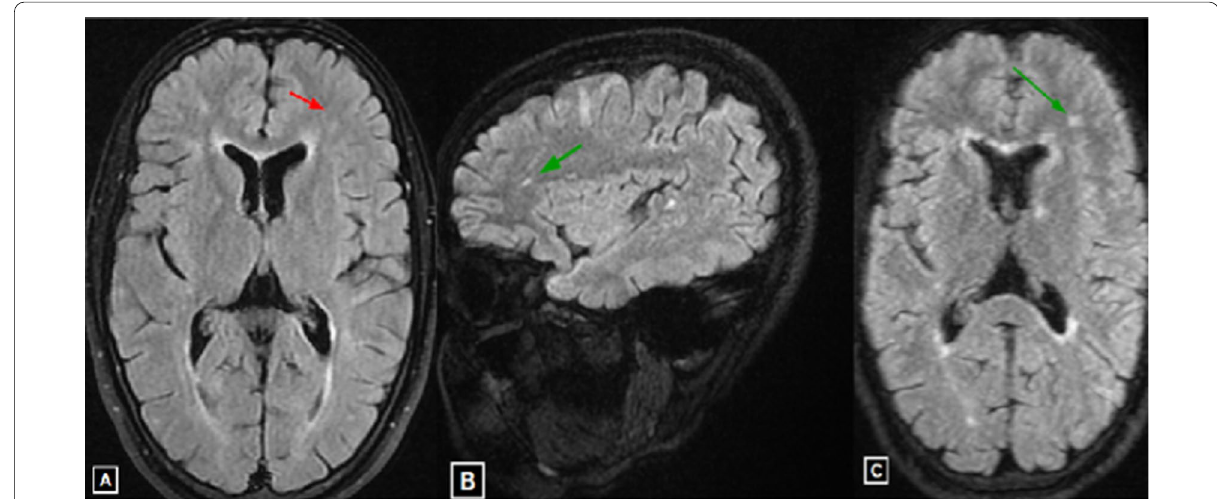
Fig. 3 Left DWM lesion: A DWM MS lesion is not visible in 2D FLAIR (red arrow at A ), is bright and well defined (green arrows at B and C ) in 3D FLAIR and its MIP reconstruction